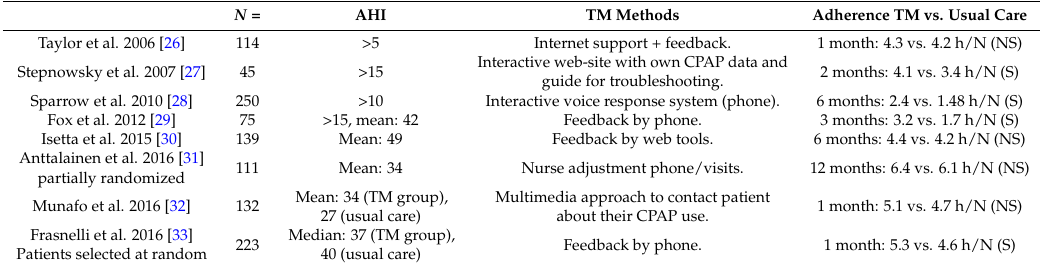
Table 1. Results of the randomized studies comparing telemedicine follow-up versus standard care for CPAP patients. AHI: apnea-hypopnea index; TM: telemedicine; CPAP: continuous positive